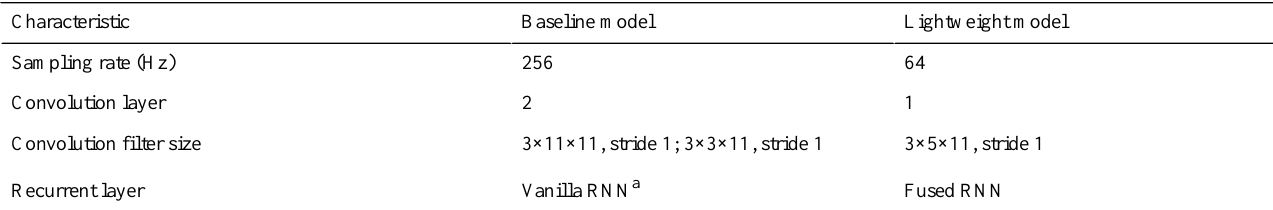
Table 2. Comparison of the baseline and lightweight models.